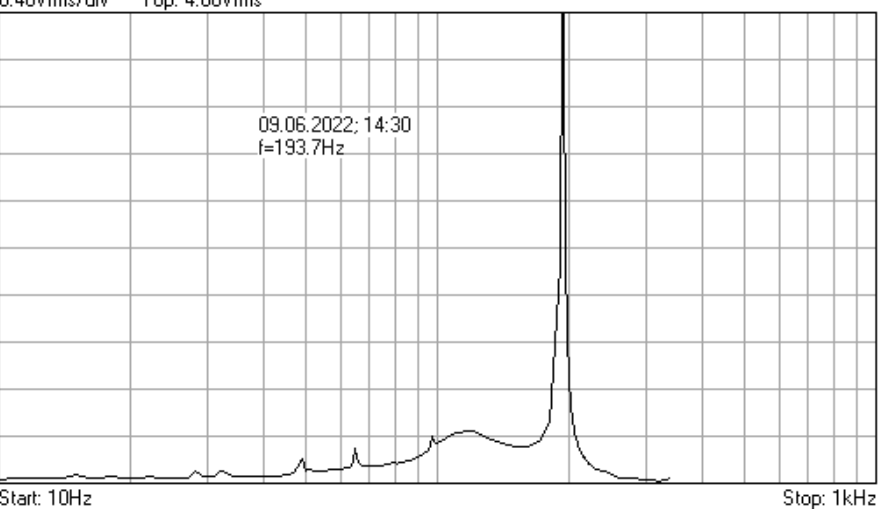
Figure 8. Frequency response function recorded after 523,800 cycles with frequency 194 Hz.